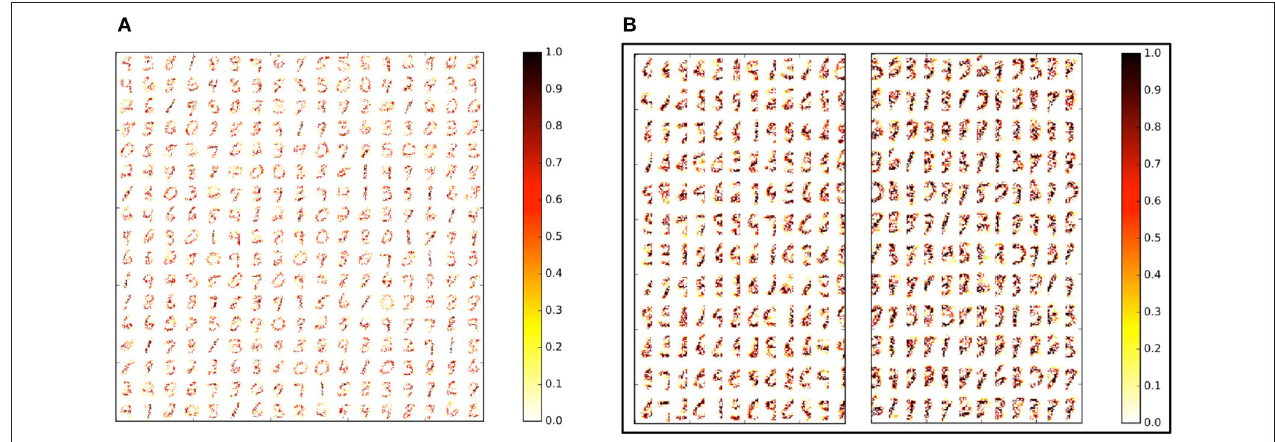
FIGURE 6 | (A) Sparse representations of MNIST digits (28 × 28 in dimension) self-learned by a Liquid-SNN of 400 neurons (80% of which are excitatory) in the weight of the synapses connecting the input to the liquid-excitatory neurons (320 excitatory neurons organized in a 17 × 17 grid). (B) Sparse features self-learned by